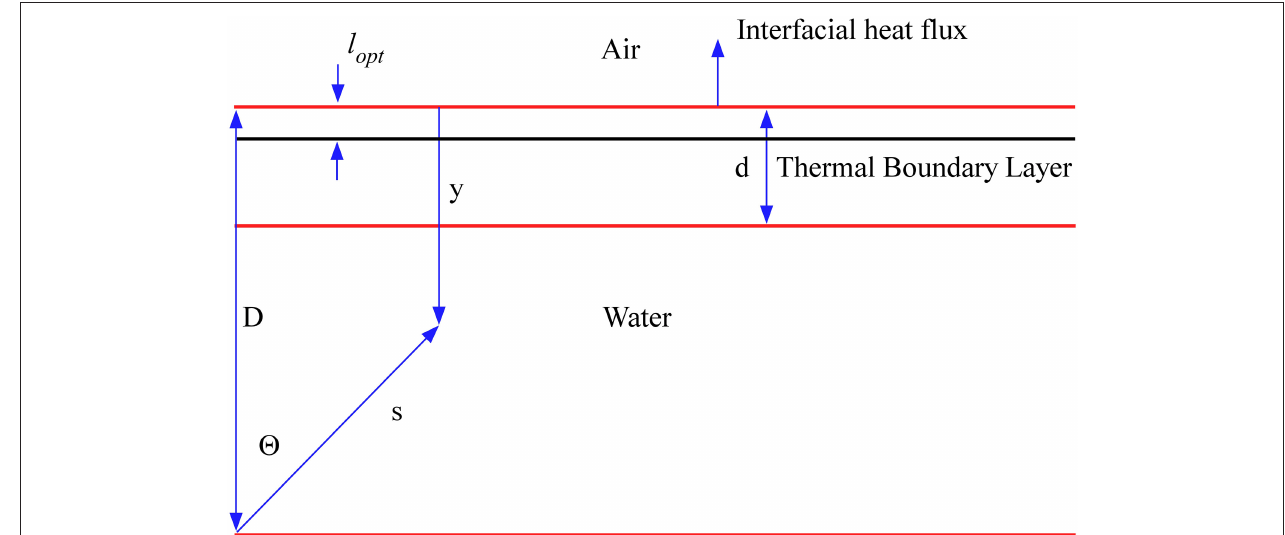
FIGURE 1 | Schematic of geometry and radiation field at an air-water